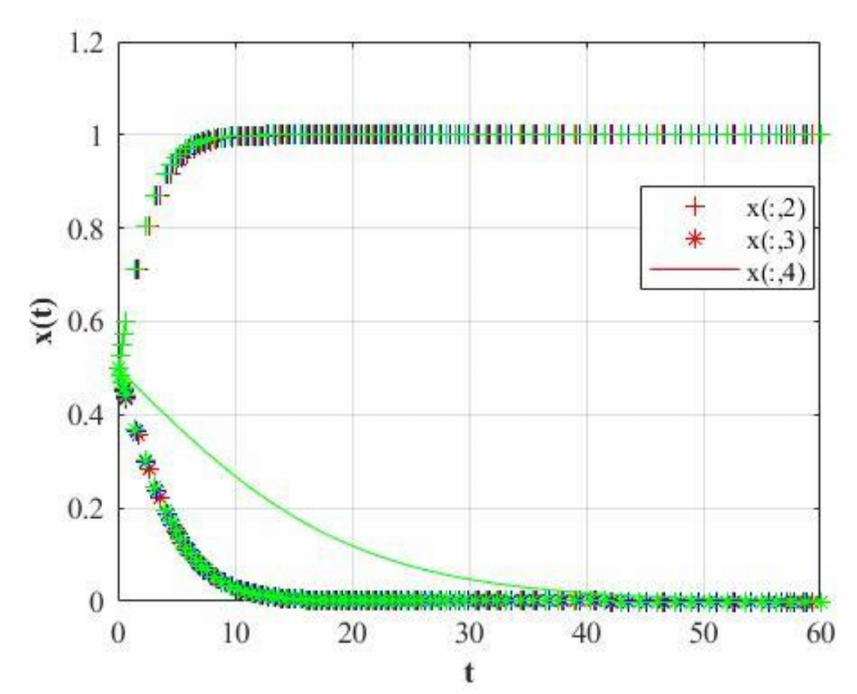
Figure 16. Change the parameter λ 1 = 0.2 (red curve), 0.6 ((blue curve), 0.9 (green curve) to take the value of the three-way strategy evolution